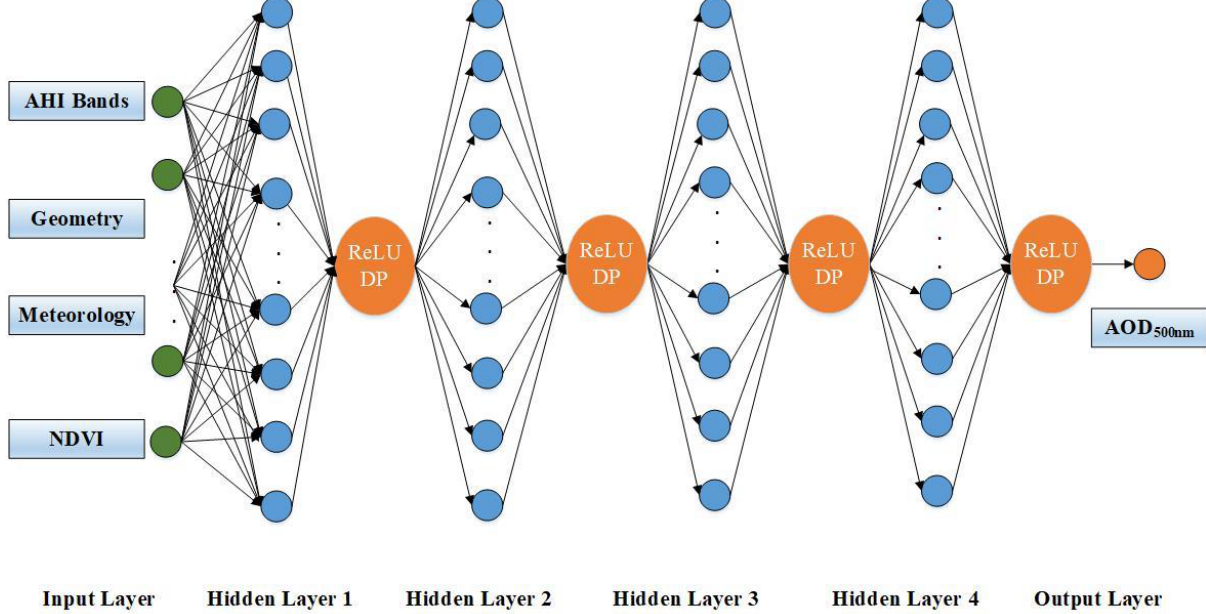
Figure 4. The architecture of the DNN model for Himawari-8/AHI aerosol retrieval (input nodes: bd1 , bd2 , bd3 , bd4 , bd5 , bd6, sza , saa , vza , vaa, sp , t2m , ws and the NDVI; output node: Himawari-8/AHI AOD at 500 nm; DP: Drop Layer and ReLU: Rectified Linear Unit Layer).